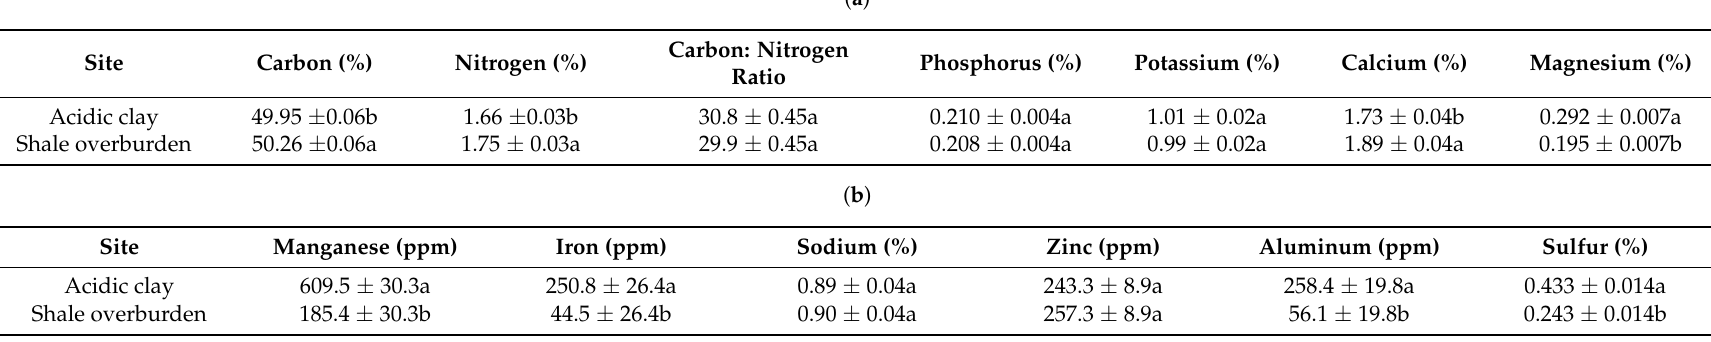
Table 4. ( a – c ) Analyses of variance (ANOVA) for foliar concentrations of nutrients and metals, including source of variation, degrees of freedom (df), mean square values (MS), p values, and coefficient of determination ( R 2 ). p values < 0.05 are in bold